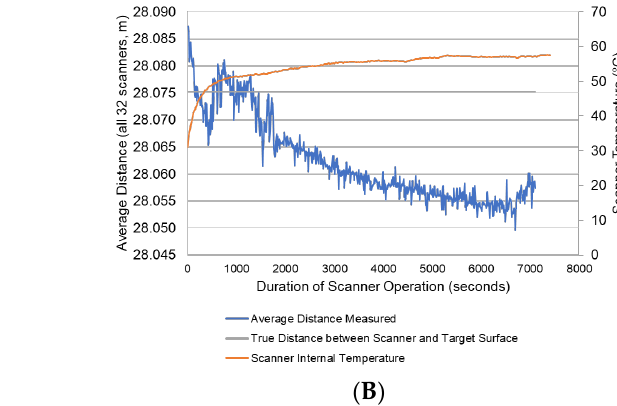
Figure 20. Average measured distance of all 32 individual channels versus internal scanner temperature and “true” distance value for both ( A ) night and ( B ) day iterations of the Velodyne ® HDL–32E absolute accuracy experiment.